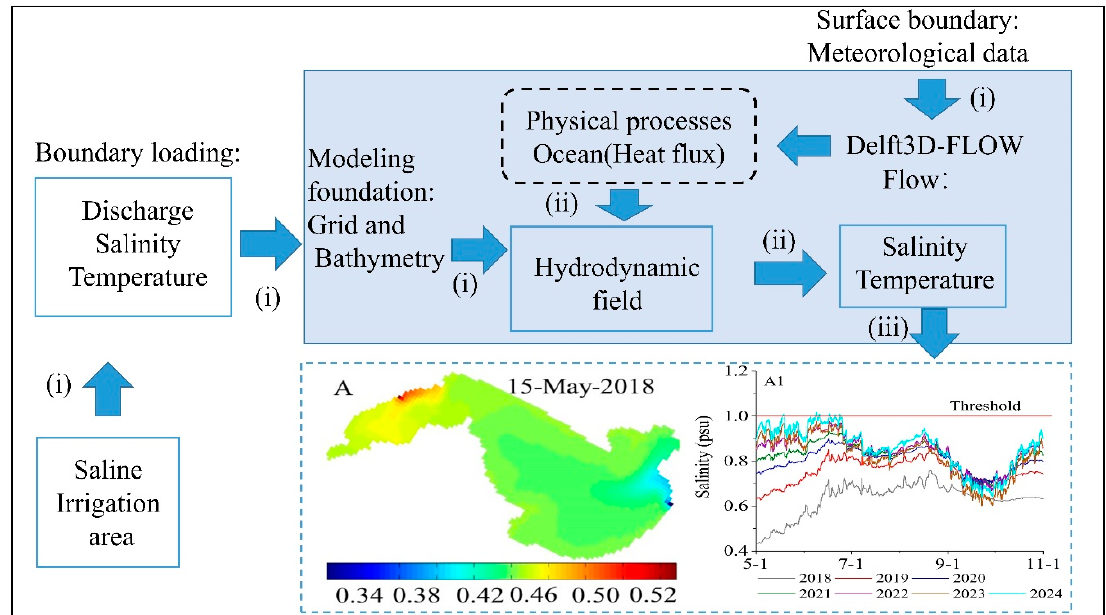
Figure 3. Conceptual diagram of integrated modeling framework, where (i), (ii), and (iii) indicate the major regions of the modeling framework.